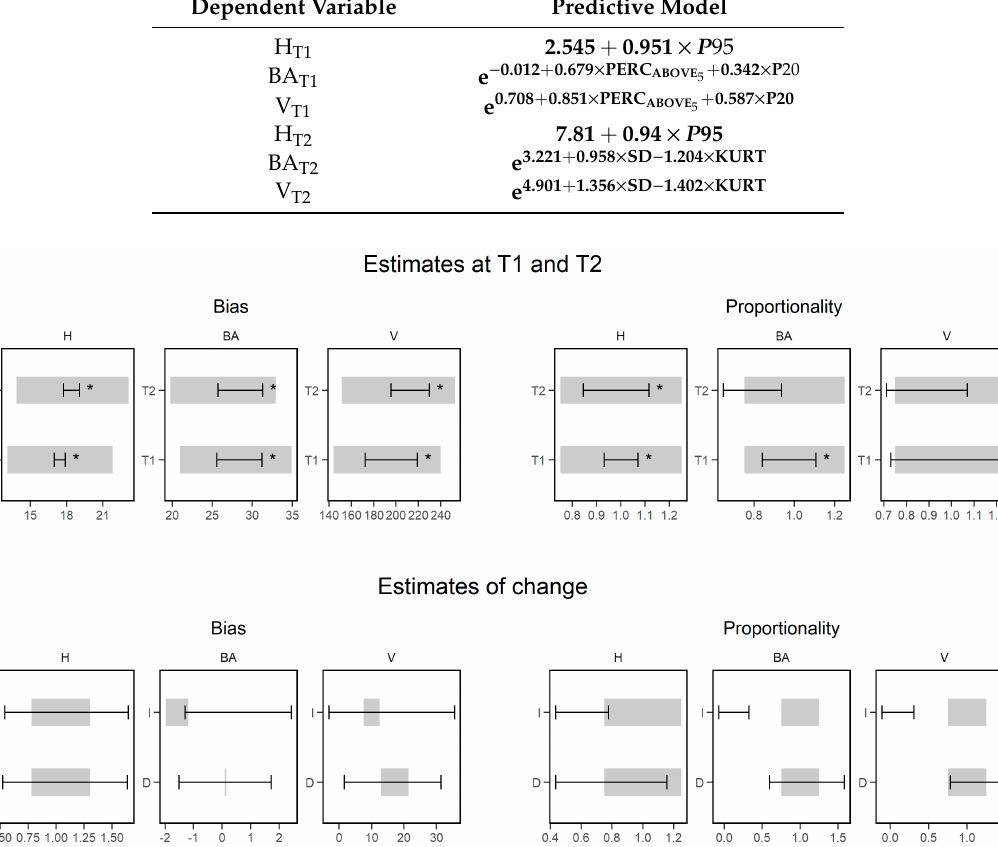
Figure 3. Results of bootstrapped equivalence tests for stand attributes modeled at T1 and T2 (top) and change estimated with the indirect (I) and direct (D) approach (bottom). In each case, the equivalence test is performed for bias and for proportionality. The grey rectangle indicates the region of equivalence, while the black crossbar depicts the 95% confidence interval. An asterisk indicates cases when the test is satisfied (i.e., confidence interval within the region of equivalence). Table 3. Predictive models for change in top height ( Δ H D ), change in basal area ( Δ BA D ), and change in total volume ( Δ V D ) under the direct approach. Predictor variables used in these models included the change in 99th percentile of point heights ( Δ P99), the change in proportion of points above 2 m ( Δ PERC_ABOVE_2), and the change in standard deviation of point heights ( Δ SD).